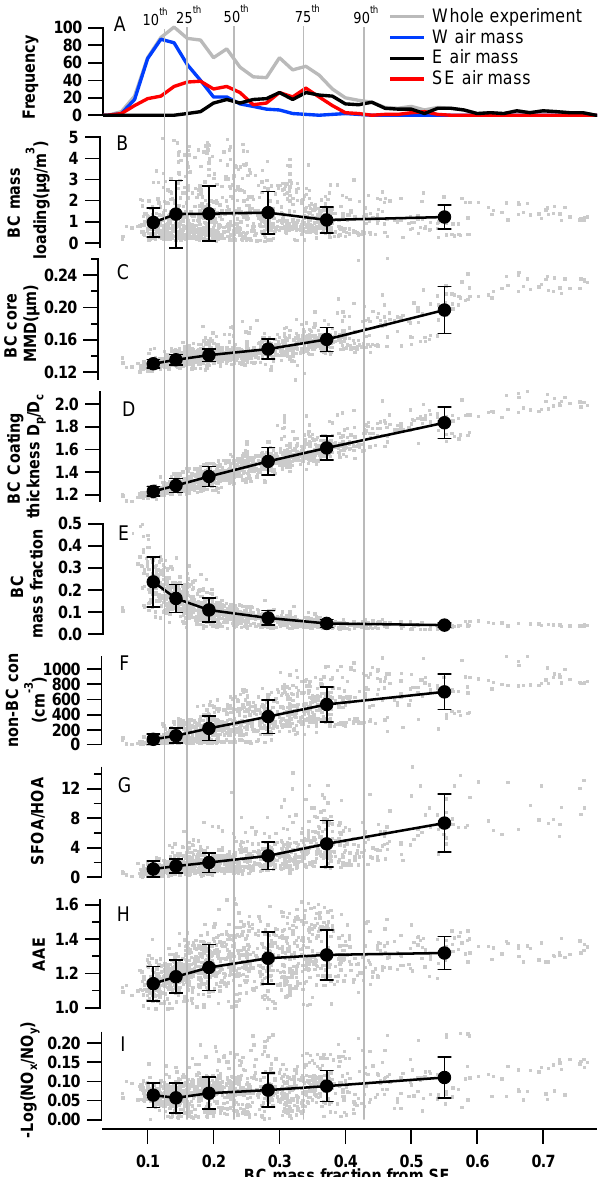
Figure 8. The BC-related properties as a function of BC sf mass fraction as attributed by the SP2. The data points are grouped ac- cording to the percentiles of BC sf mass fraction, i.e. min to 10th percentile of BC sf fraction; 10th to 25th percentile of BC sf fraction, etc. Each solid round marker shows the average within the grouped points with the error bar showing the standard deviation ( ± σ) . (a) of the histograms of BC sf mass fraction for W, E, SE air mass and for the entire experiment; (b) BC mass loadings; (c) BC core diameter; (d) BC coating thickness; (e) BC mass fraction; (f) non-BC concen- tration at 200–530nm; (g) SFOA/HOA from AMS-PMF analysis; (h) the absorption Ångström exponent calculated at λ = 470 and 950nm; (i) − Log(NO x /NO y ) .